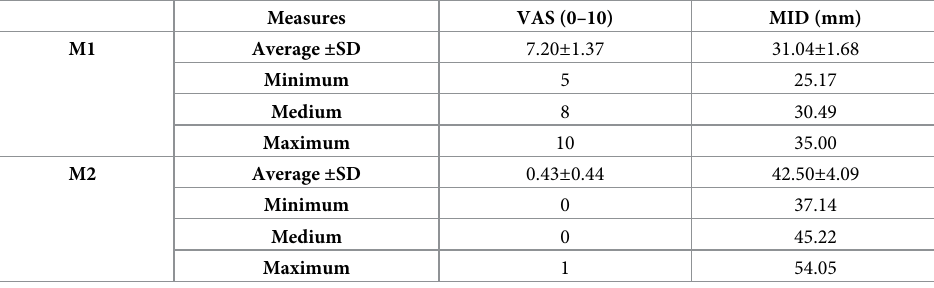
Table 2. Descriptive measures of the variables VAS and MID.